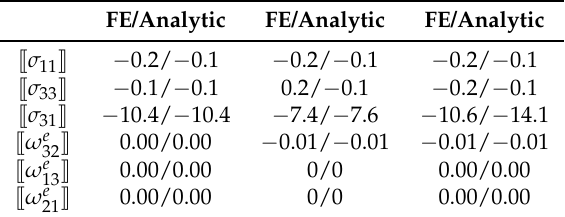
Table 5. Values of ˆ σ (MPa) and ∇ g provided by the FE simulation 5 and used to compute the analytic ∼ formulas (28)–(30) and (32) (top). Comparisons of the values of [[ σ simulation 5 and those computed from the analytic formulas (bottom).